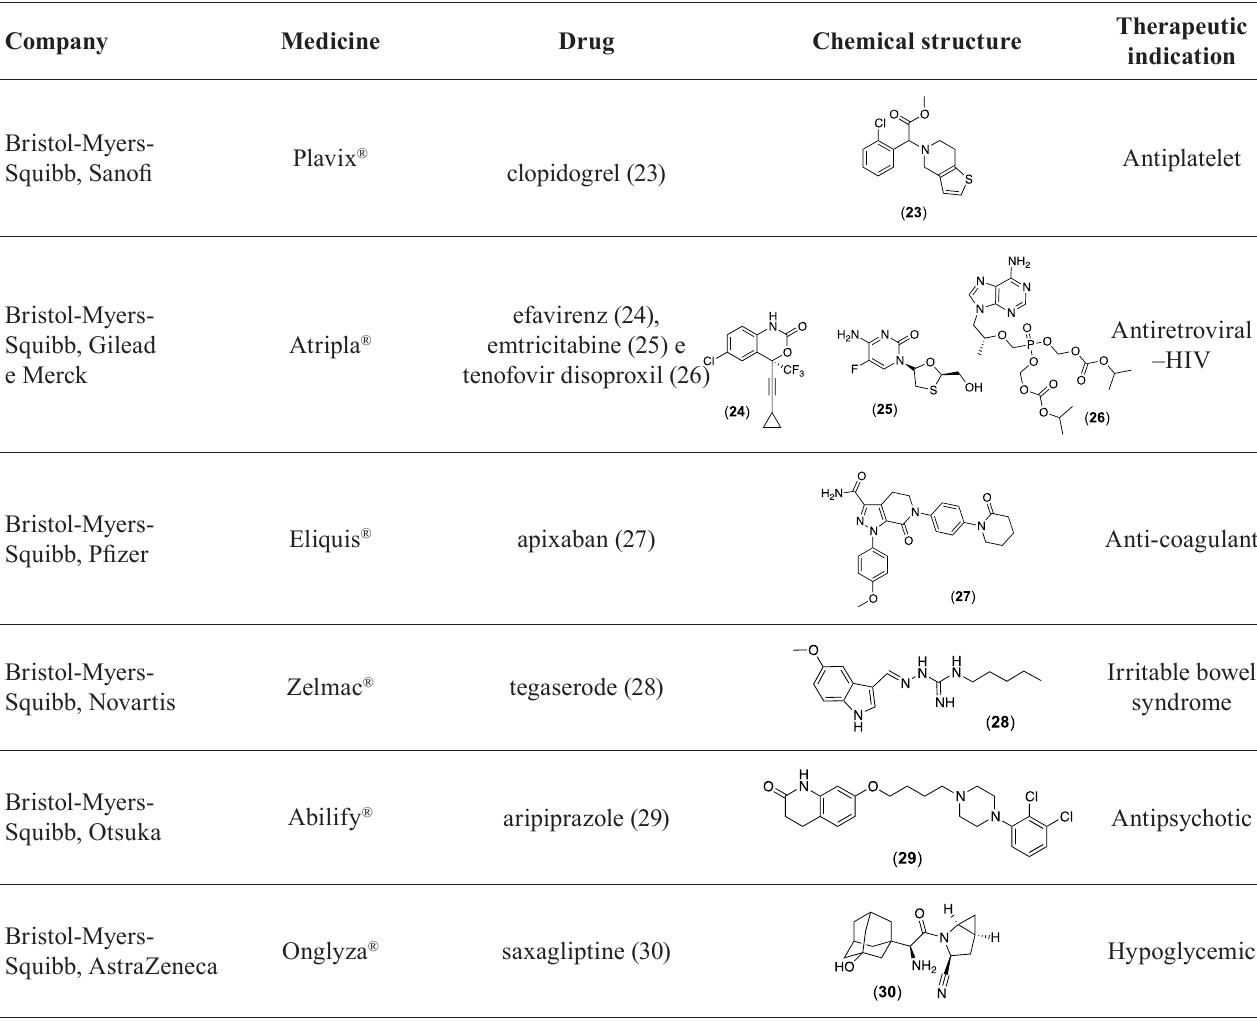
TABLE I - D rugs developed by Bristol-Myers-Squibb co-partnerships with other pharmaceutical companies (Abou-Gharbia, Childers,